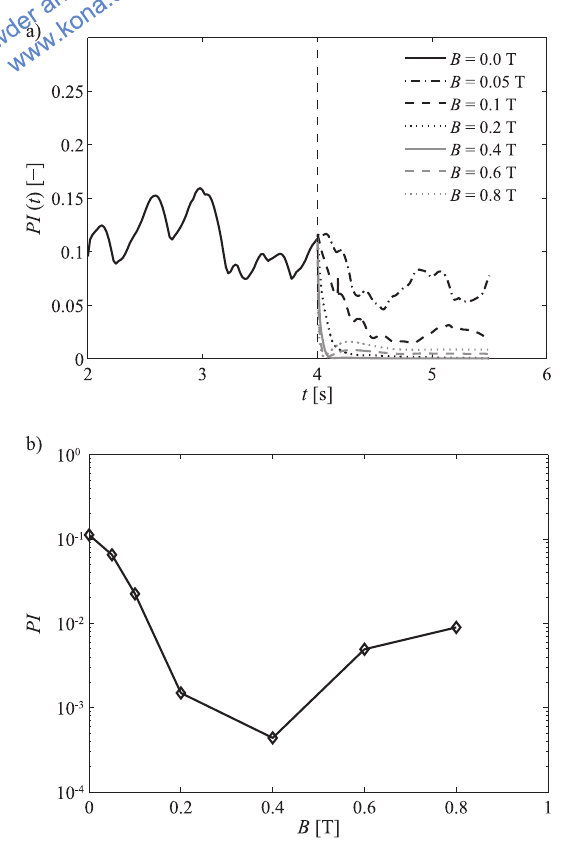
Fig. 4 Time evolution of the polydispersity index at different magnetic field intensities (a) and relevant time-averaged values (b). d p = 300 µm; U = 2.5 U mf